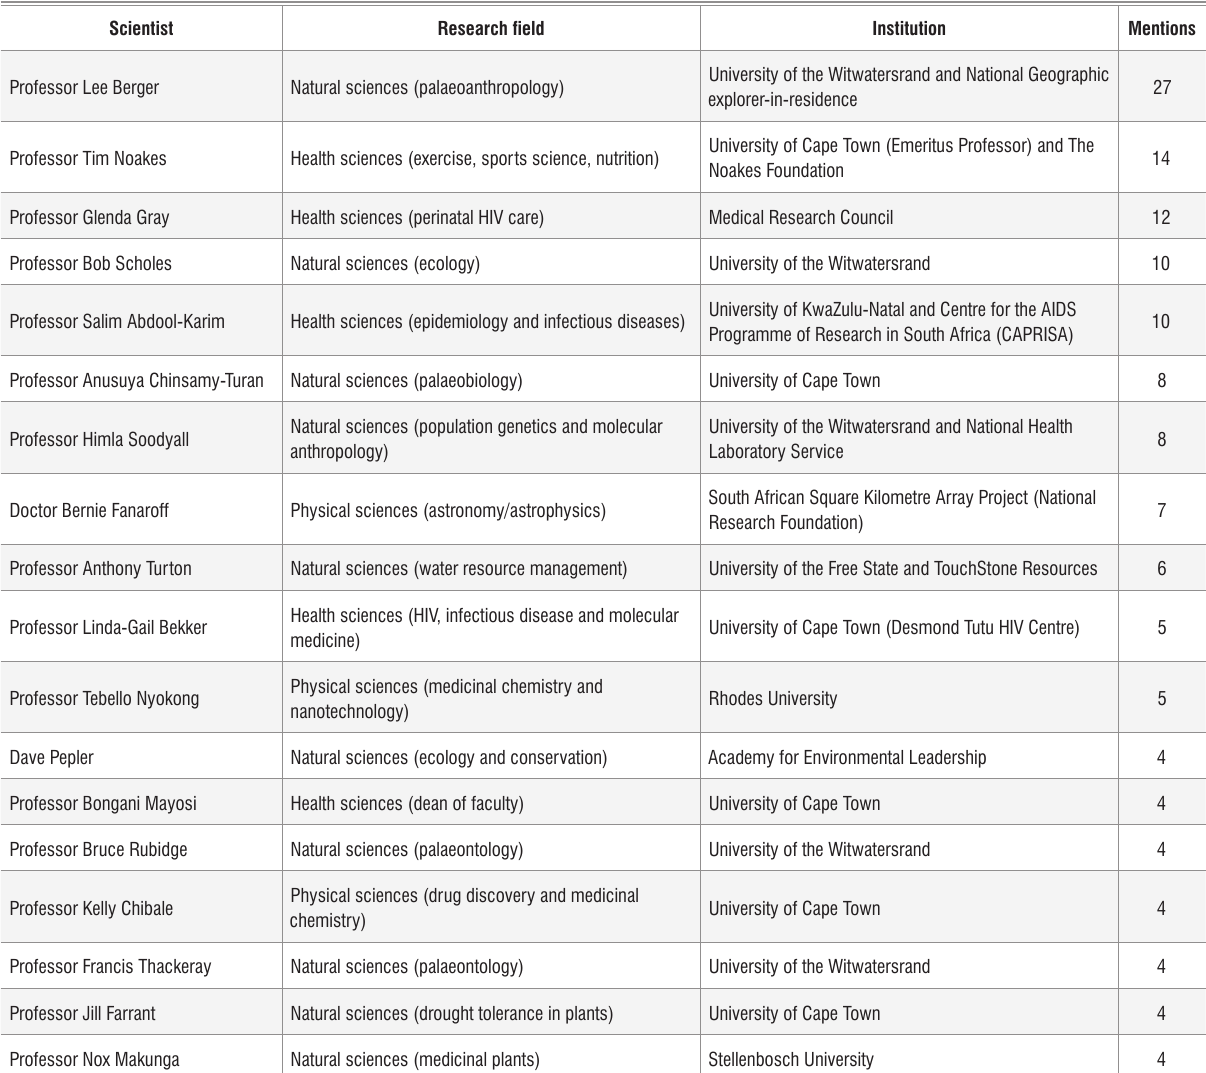
Publicly visible scientists mentioned by four or more members of the science–media panel